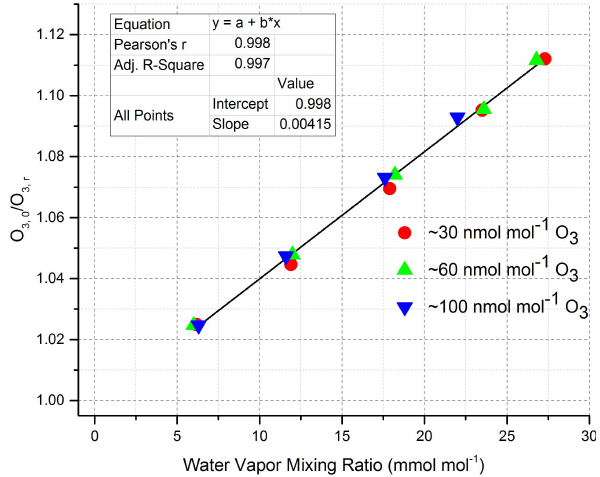
Fig. 3. Ratio of ozone signal in dry air (water vapor levels less than 0.1mmolmol − 1 (O 3 , 0 )) to ozone signal at water vapor level r (O 3 ,r ) versus water vapor mole fraction. The points are color-coded according to the amount of ozone in the sample air. The solid lines represent results from linear regression analyses. The results from the linear regression analyses are shown in the table insert.